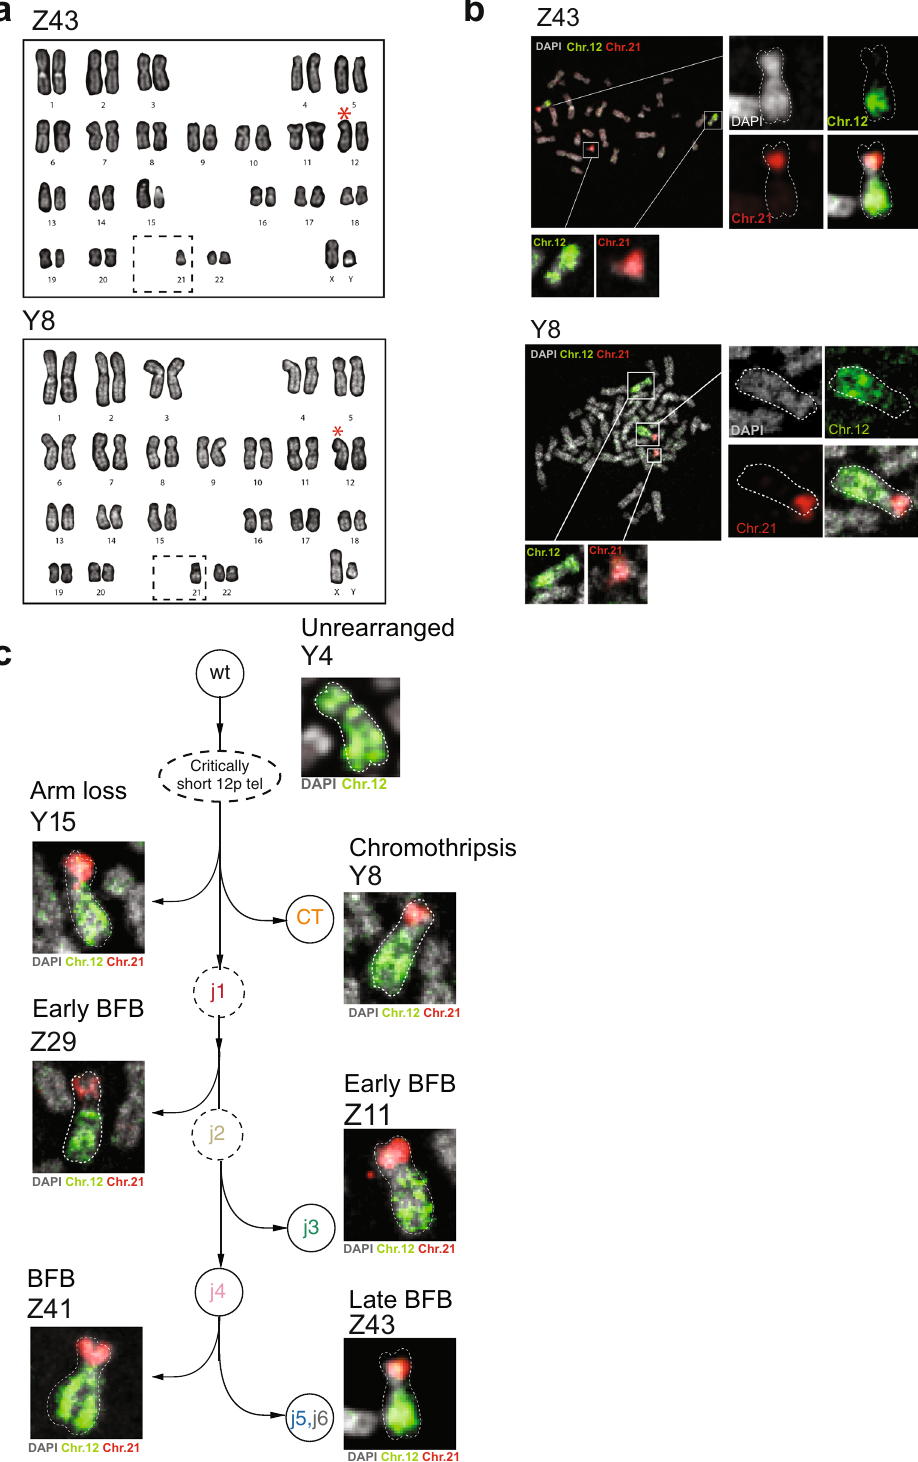
Fig. 6 Resolution of BFB cycles in telomere crisis. a DAPI banded karyotypes of post-crisis clones Z43 and Y8 showing a rearranged chromosome 12 (red star) and loss of one copy of chromosome 21 (dashed box) (see also Supplementary Fig. 6A). b Representative metaphase spreads of clone Z43 and Y8 hybridized with whole-chromosome pairs for chromosomes 12 (green) and 21 (red). DNA was stained with DAPI (gray). Insets show enlarged images of the 12 – 21 derivative marker chromosome and intact copies of the sister alleles (see also Supplementary Fig. 6B). c Images of derivative chromosome 12:21 from representative clones from each branch of the evolution of chromosome 12 post-crisis (according to the analysis in Fig. 5c). Metaphases were hybridized with whole-chromosome pairs for 12 (green) and 21 (red). DNA was stained with DAPI